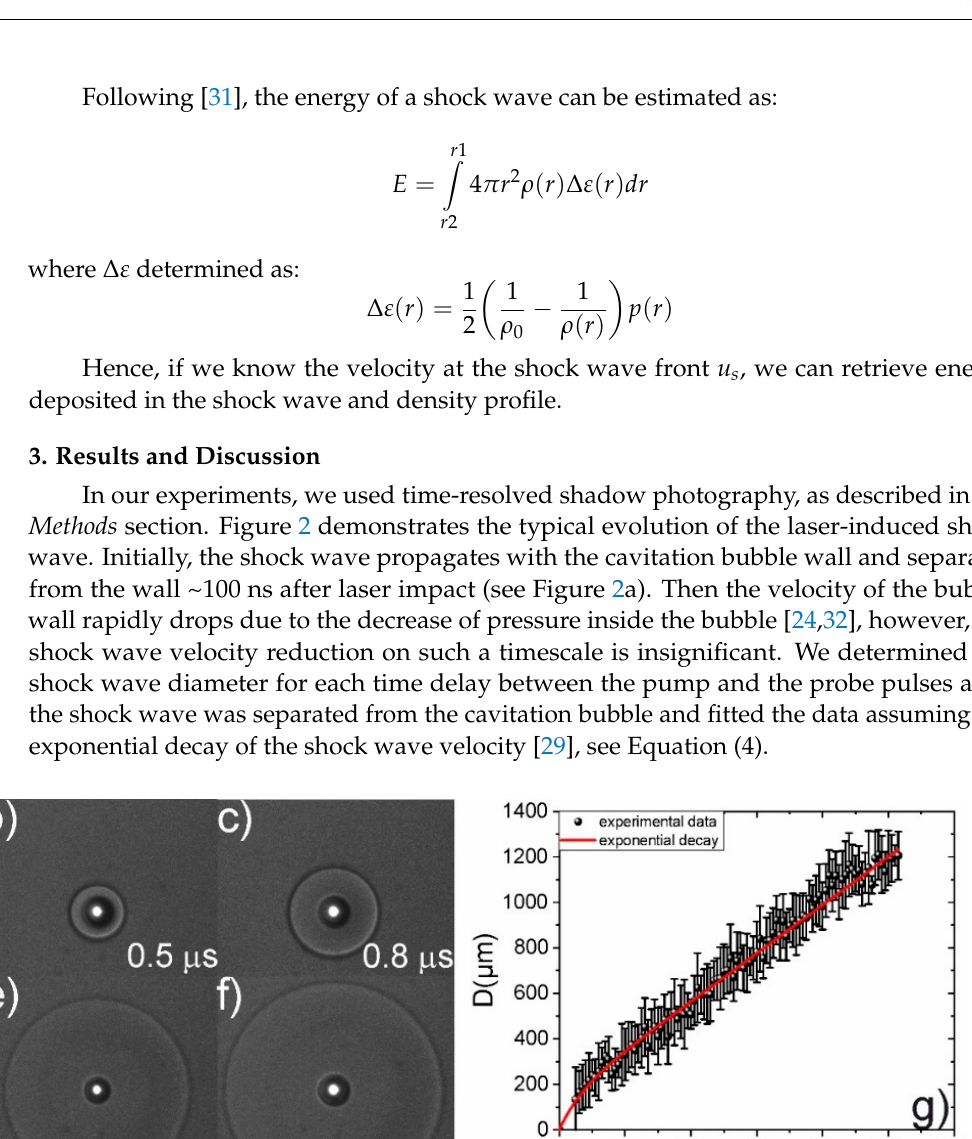
Figure 3. ( a , b ) Dependence of the sound velocity (black line), shock wave velocity (red line) and the Mach number—the ratio of flow velocity to the local speed of sound (blue dots) on the pres ‐ sure inside the cell for different temperatures. Dash–dot line indicates the Widom line (the